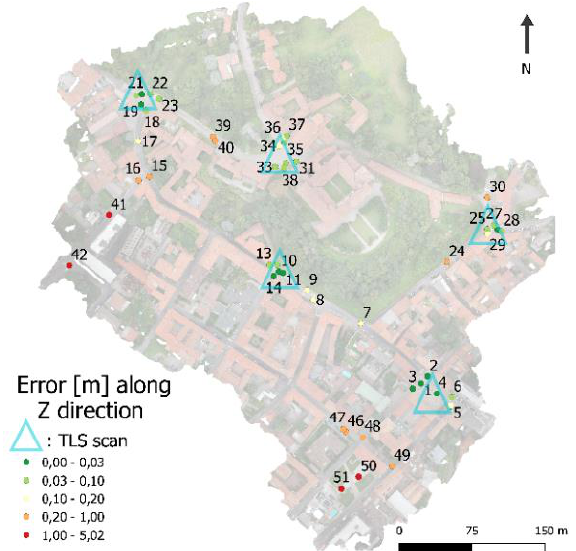
Figure 10. Accuracy check on 48 CPs when testing the GCSs method. Numbers correspond to the CPs ID. Basemap: orthophoto resulting from the photogrammetric survey performed with UAV DJI Spark.